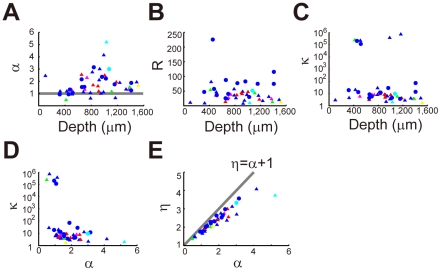
Neuron-dependence of parameter values of the double gamma process.(A)–(C) Optimal values of beta-2 fitting parameters α, R and κ for pyramidal (triangles) and fast-spiking (circles) neurons recorded at various depths of the cortex. As in
Figure 2
, the color code indicates the motor components represented by the individual neurons. The values were determined by nonlinear least square method (
Materials and Methods
). (D) The relationship between α and κ values over the recorded neural population. (E) The relationship between α and η values. The latter was determined by linear regression of the power-law tails of ISI distributions (see
Figure 2C
).